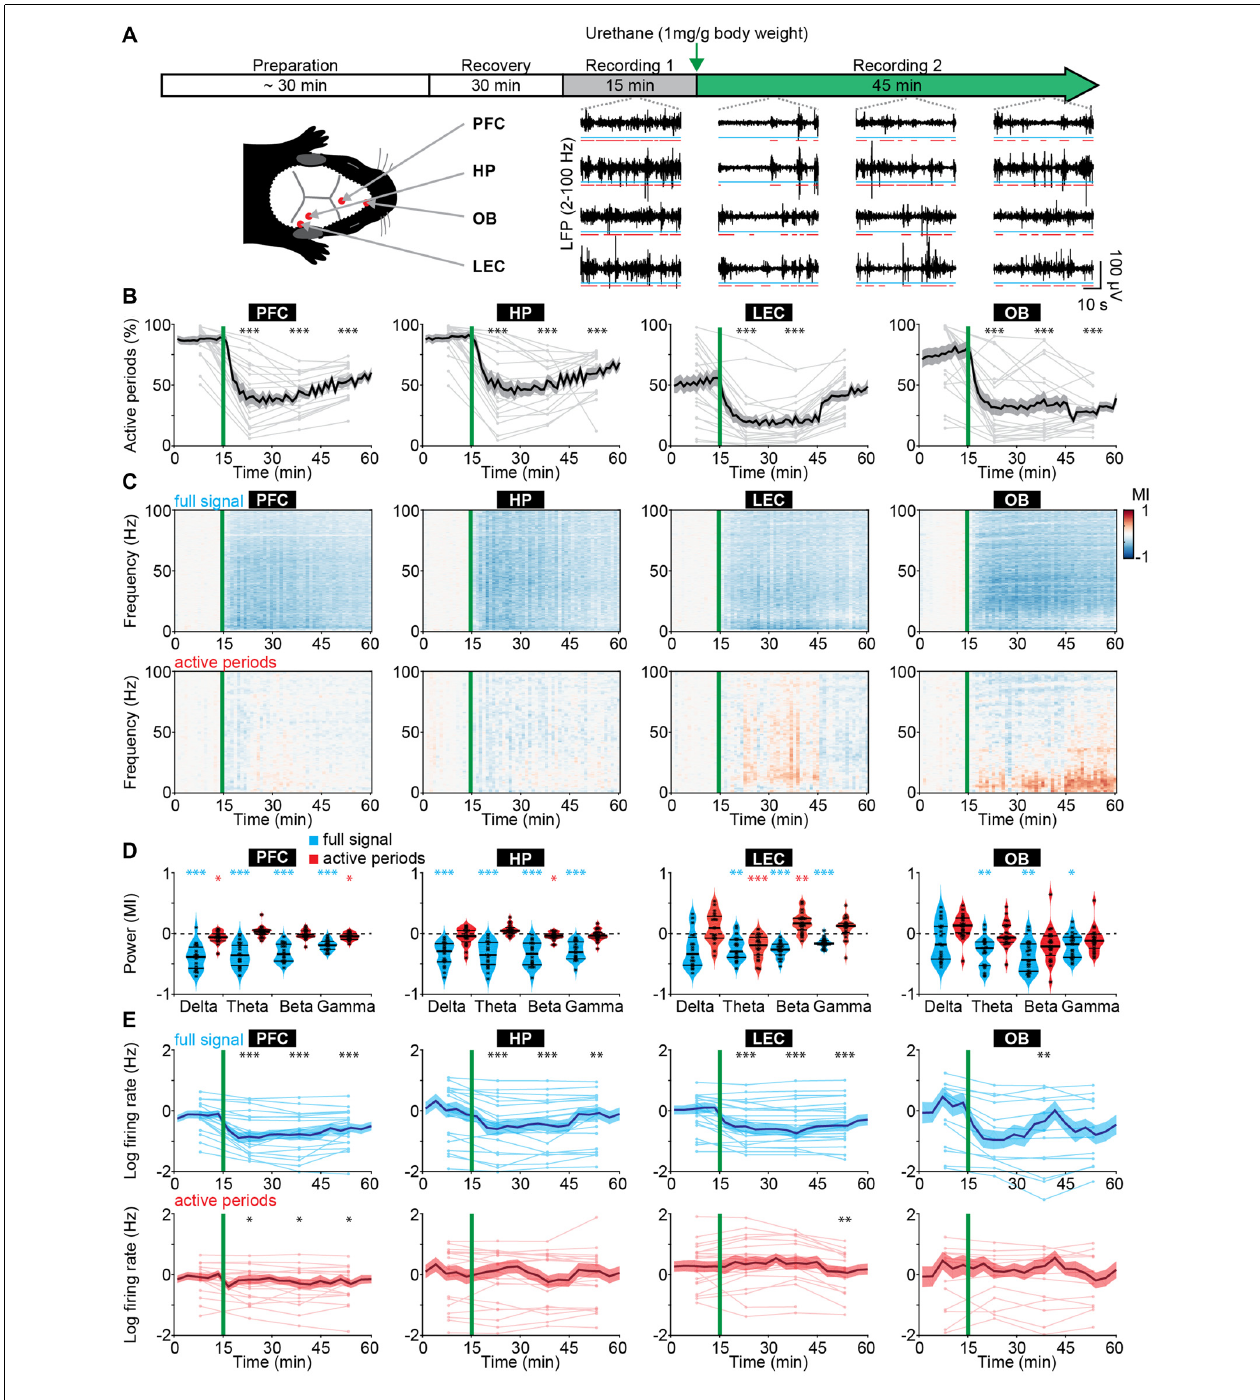
FIGURE 1 | Frequency-unspecific dampening of neuronal activity during urethane anesthesia in neonatal mice. (A) Schematic representation of experimental paradigm and recording sites as well as characteristic local field potential (LFP) recordings of discontinuous activity in the prefrontal cortex (PFC), HP, lateral entorhinal cortex (LEC), and olfactory bulb (OB) of neonatal mice (P8–10) during non-anesthetized and urethane-anesthetized state. Time windows of active periods are marked by red lines. (B) Line plots displaying the relative occurrence of active periods normalized to total recording time in PFC, HP, OB and LEC before and after urethane injection. (C) Color-coded MI of power spectra for full signal (top) and active periods (bottom) recorded in PFC, HP, LEC and OB of neonatal mice before and after urethane injection. (D) Violin plots displaying the MI of power in delta (2–4 Hz), theta-alpha (4–12 Hz), beta (12–30 Hz) and gamma (30–100 Hz) frequency bands for full signal (blue) and active periods (red) recorded in the PFC, HP, LEC and OB. (E) Line plots displaying multi-unit activity (MUA) rates during full signal (blue) and active periods (red). In (B,C,E) green lines correspond to the time point of urethane injection.